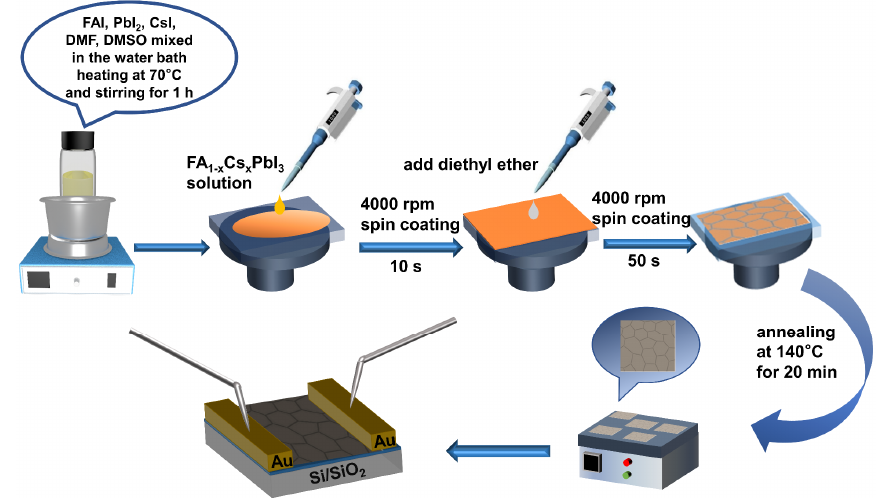
Figure 1. Flow chart of FA 1 − x Cs x PbI 3 thin- fi lm device preparation.